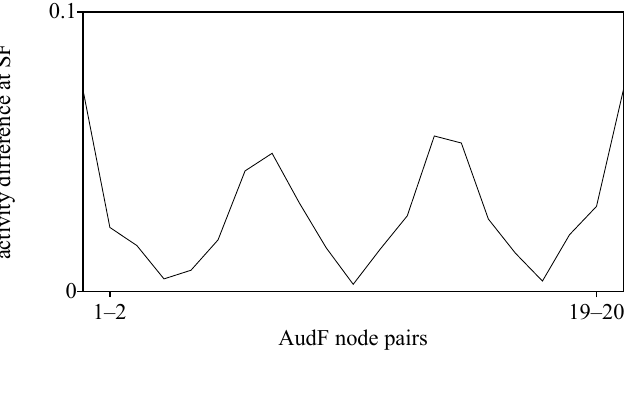
Figure 22: The discrimination curve. The peaks at the edges represent the difference between nodes 1 and